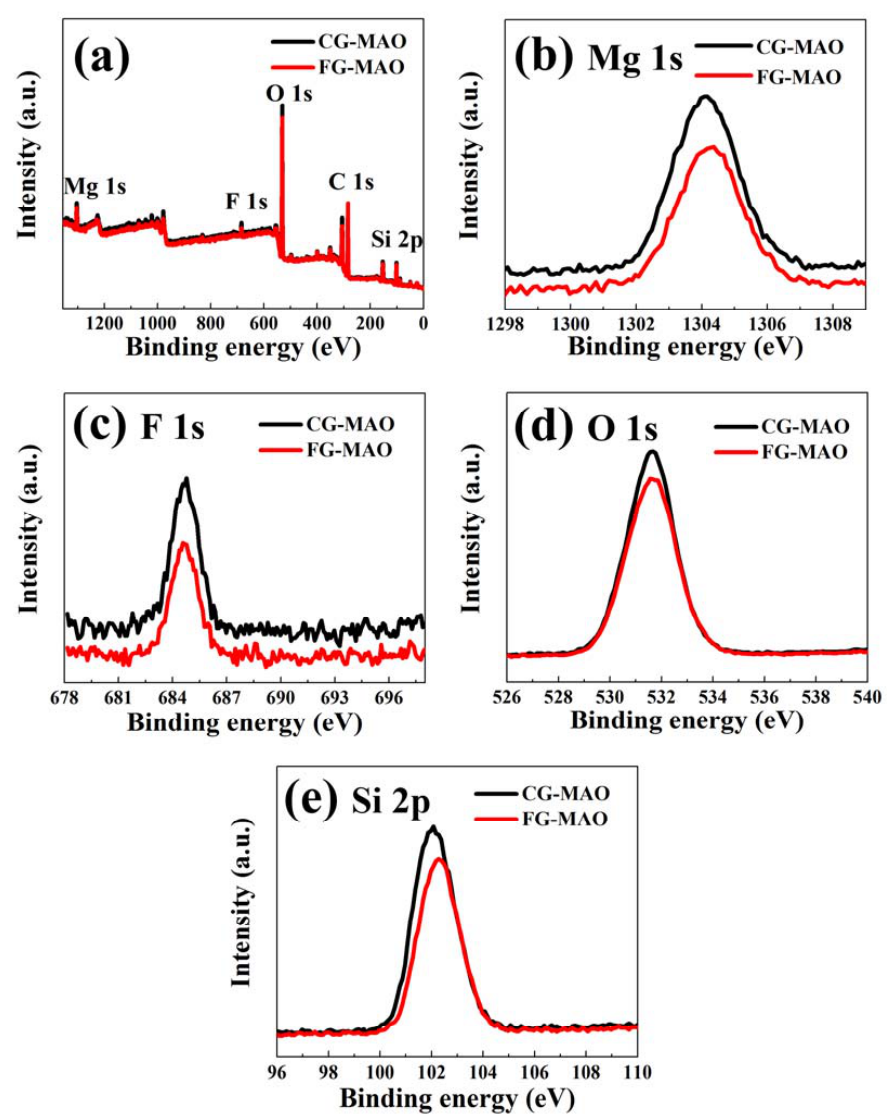
Figure 5. ( a ) X ‐ ray photoelectron spectroscopy (XPS) survey spectra; ( b ) Mg 1s; ( c ) F 1s; ( d ) O 1s and ( e ) Si 2p high ‐ resolution spectra for CG ‐ MAO and FG ‐ MAO samples.